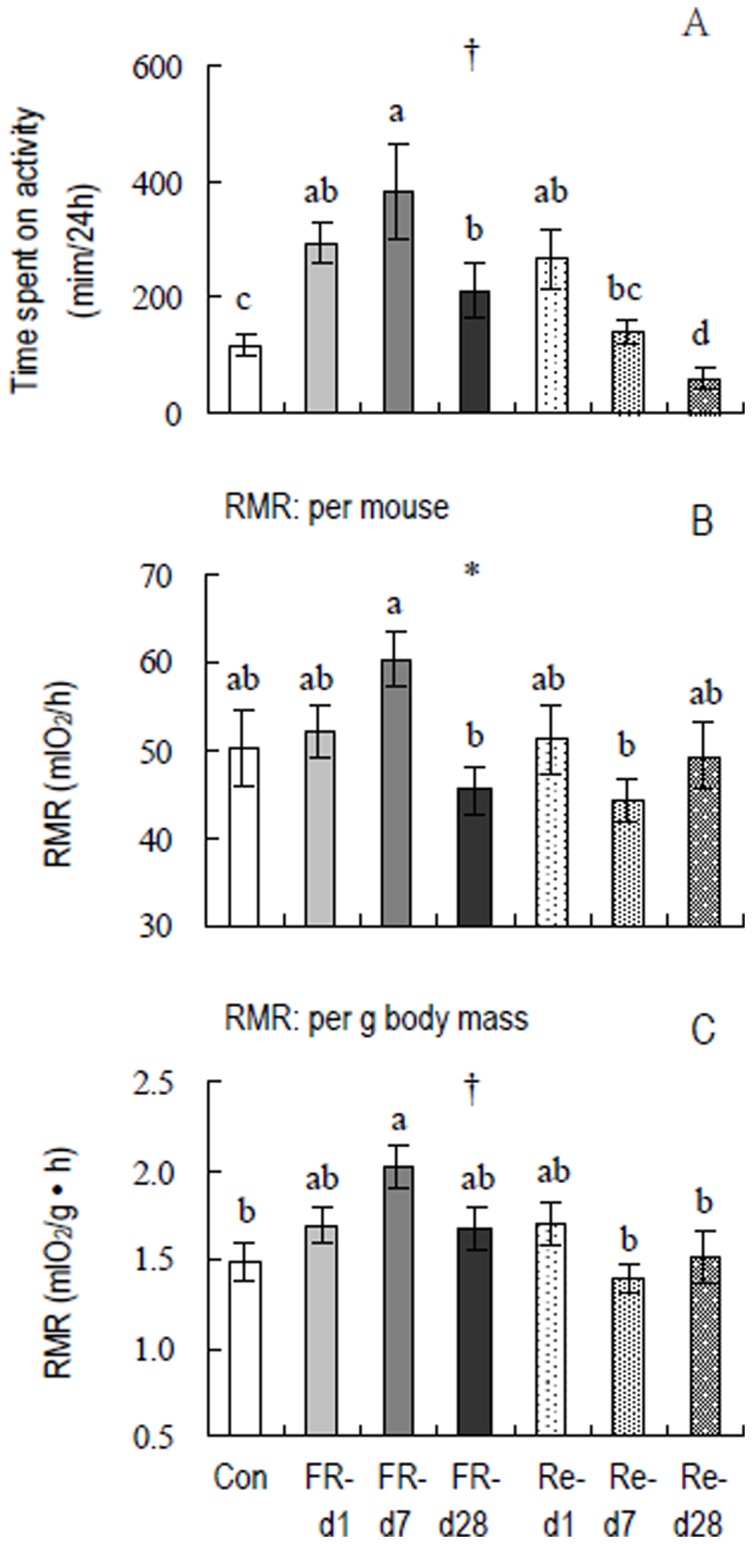
Time spent on activity (A) and resting metabolic rate (RMR) per mouse (B), and per g body mass (C), in striped hamsters subjected to food restriction and refeeding.Groups are the same as in Fig. 2. Effect of food restriction and refeeding is significant: *, P<0.05 and †, P<0.01. Different letters above the columns indicate significant differences between the seven groups (P<0.05).